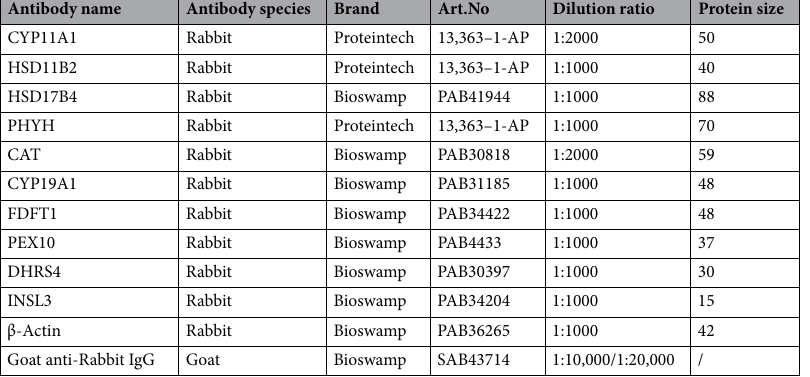
Table 3. Antibody information for Western blotting